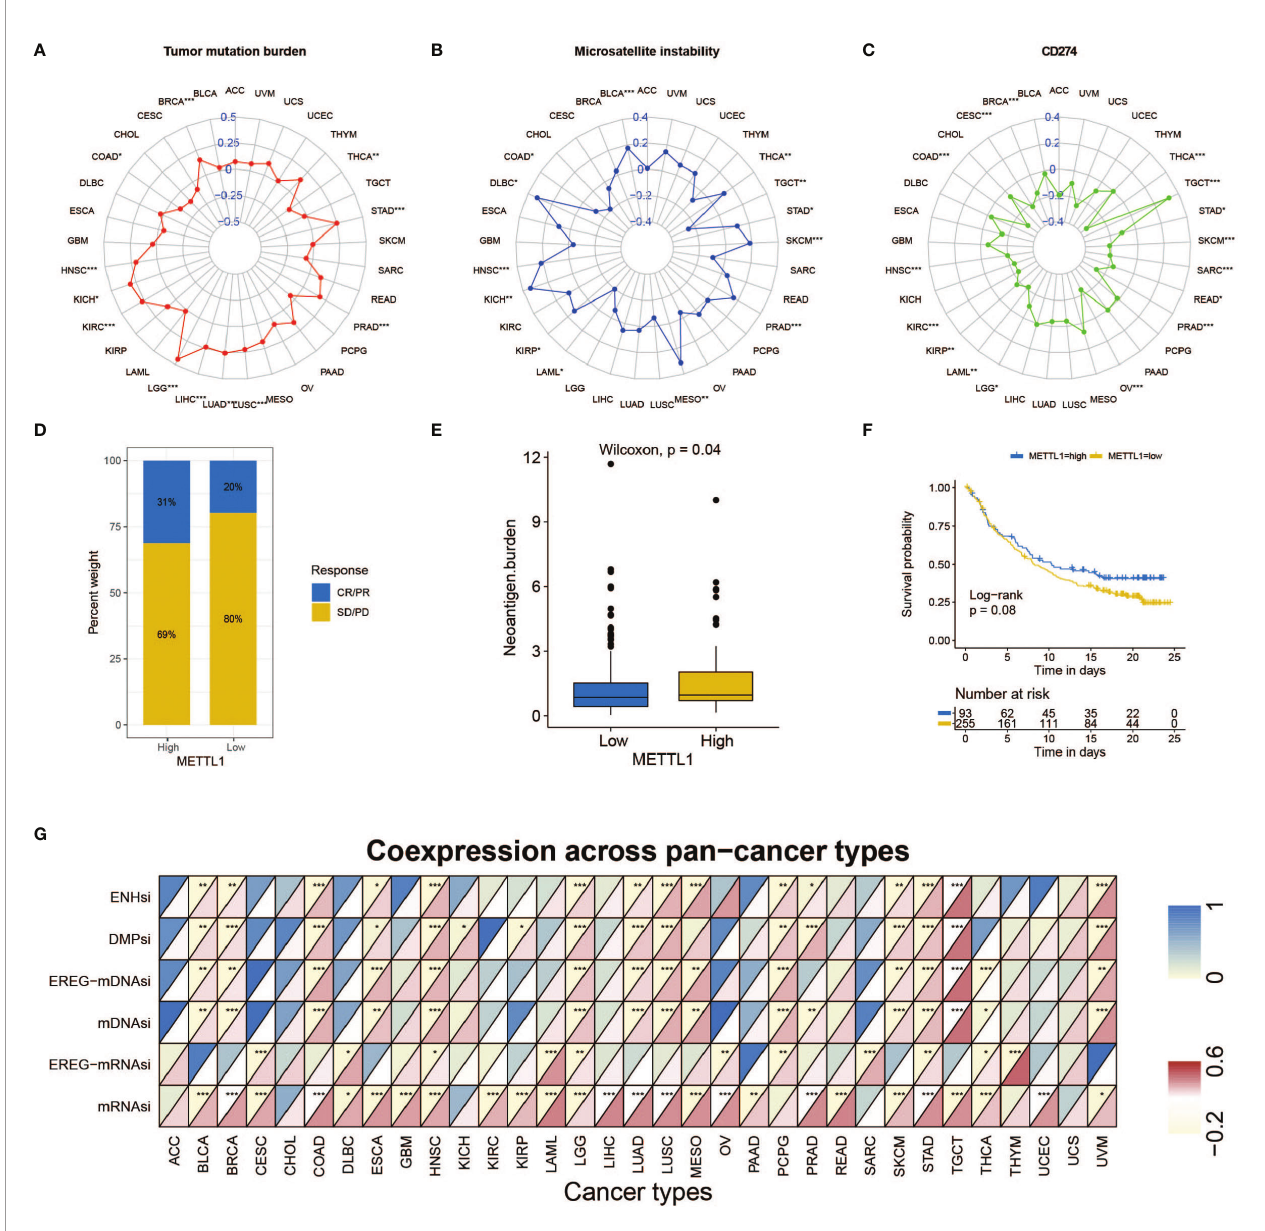
FIGURE 7 | Role of METTL1 expression in response to ICB therapy. (A-C) Radar chart visualized the relationship between METTL1 expression and TMB (A) , MSI (B) and CD274 expression value respectively (C) . The dots in the radar chart indicates the correlation coef fi cient. (D) The column chart showed the proportion of patients with low or high METTL1 expression who responded to PD-L1 block immunotherapy. (E) Differences in neoantigen burden between low and high METTL1 expression groups (P = 0.04, Wilcoxon test). (F) Kaplan-Meier curve showed the survival of the high and low METTL1 expression patient groups in anti-PD-L1 immunotherapy cohort (IMvigor210 dataset; P = 0.08, Log-rank test). (G) Heatmap exhibited the relationship between METTL1 expression and stemness indices among pan-cancer. The upper half of each grid exhibited the p value and the lower half exhibited the correlation coef fi cient. * means P < 0.05; ** means P <0.01; *** means P <